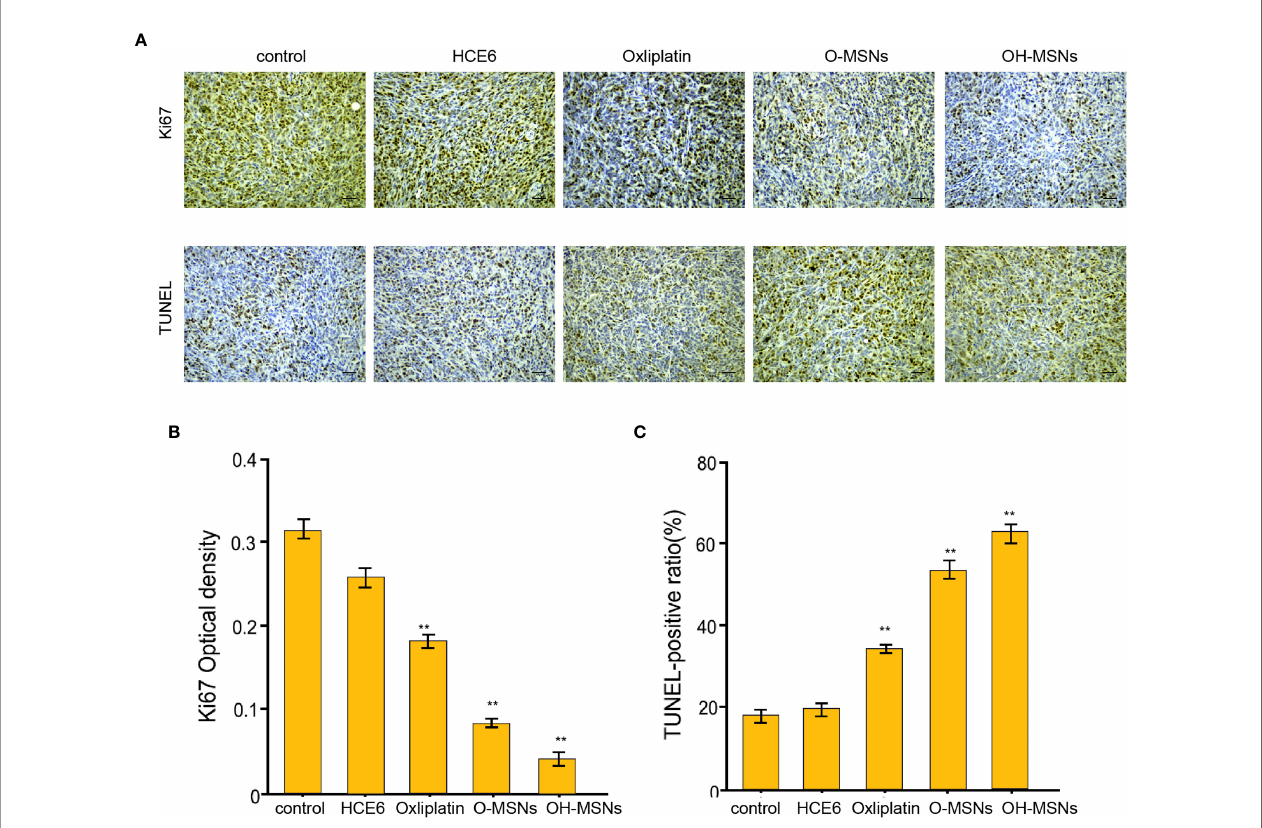
FIGURE 8 | Ki67 and Tunel staining of mouse tumor sections. (A – C) The nude mice (n=4) were injected with FRH0201 cells and were treated as the indicated labeling. (A, B) The levels of ki-67 were measured by IHC. (A, C) The apoptosis was detected by TUNEL analysis. Data are presented as mean ± SD. Statistic signi fi cant differences were indicated: **P <